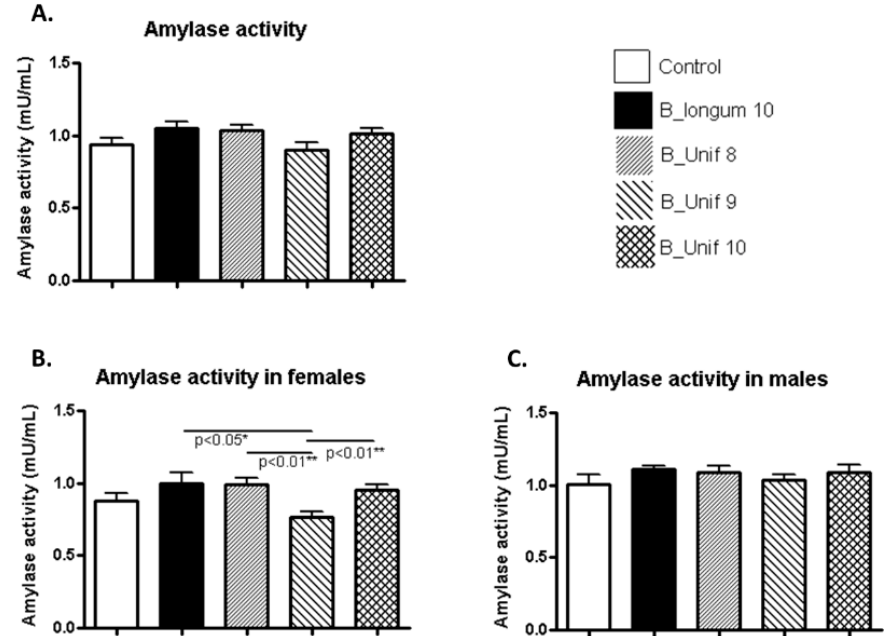
Figure 3. Amylase activity measured in the serum of the experimental groups. A , Amylase activity (mU/mL) at the end of the study for all groups (50 animals, n = 10 per group). B , Amylase activity (mU/mL) at the end of the study for females in all groups (25 animals, n = 5 per group). C , Amylase activity (mU/mL) at the end of the study for males in all groups (25 animals, n = 5 per group). Measurements were made in duplicate. Statistical significance was considered when p < 0.050. * p ≤ 0.05, ** p ≤ 0.01.